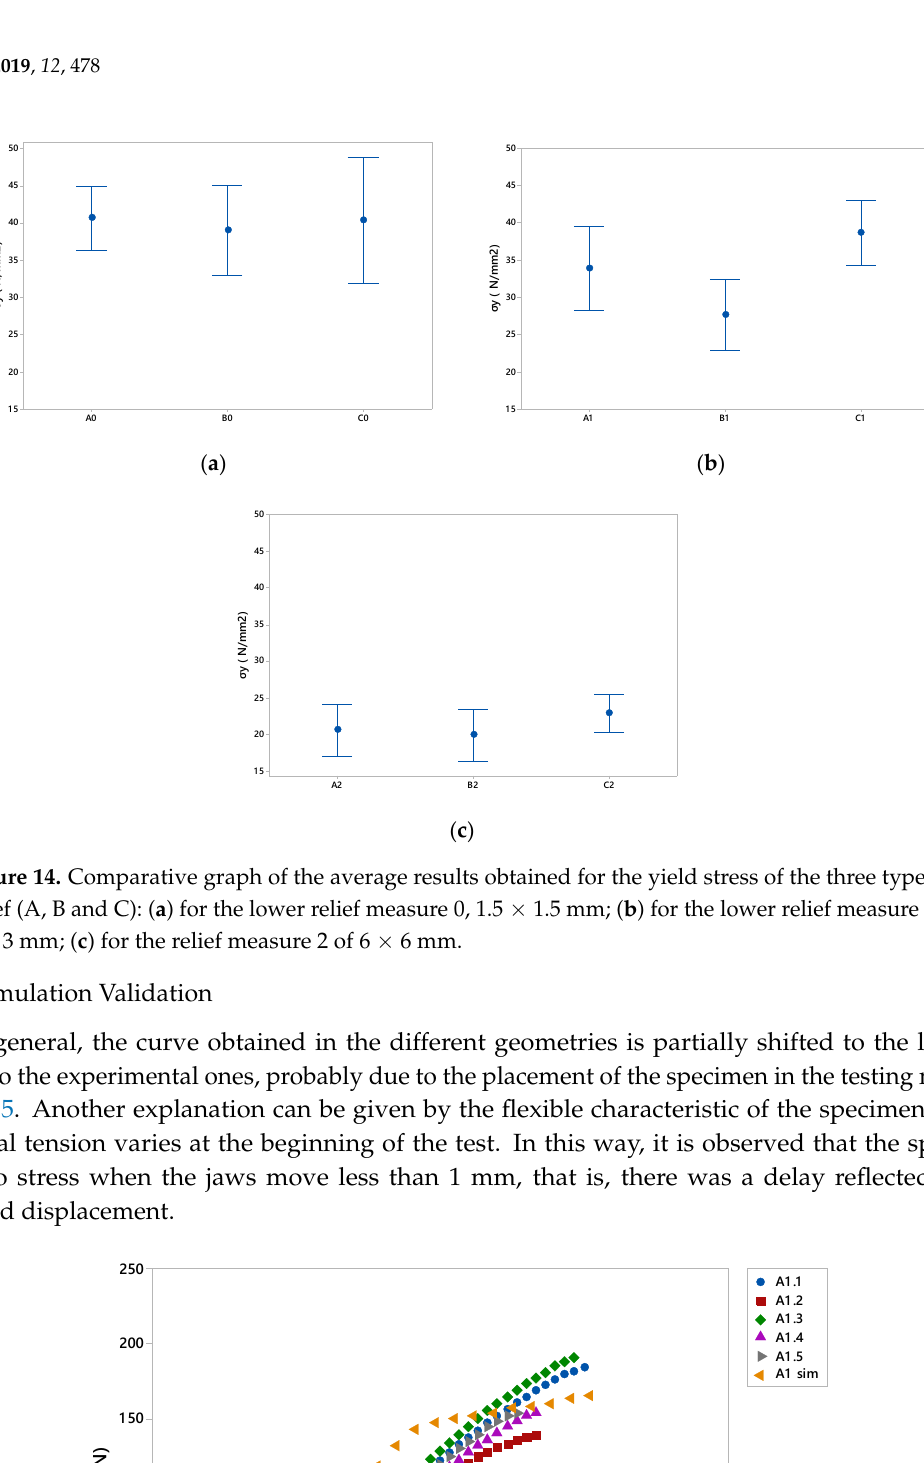
12 of 19 Figure 13. Data of the yield stress with respect to the section of the relief. The results of the tests with the specimens with relief size 1, Figure 14b, evidence that there are